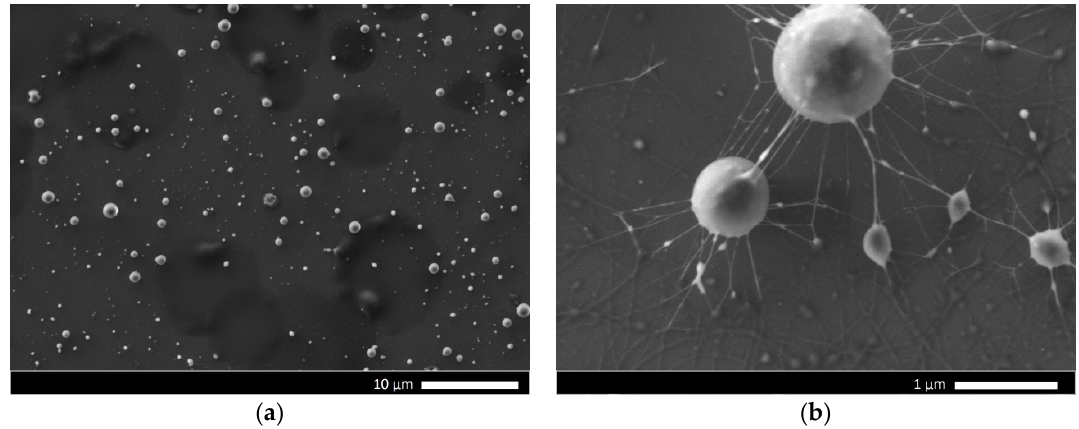
Figure 10. SEM photomicrographs of nanoparticles electrosprayed from the hyaluronic acid solutions with concentration 10.0 mg/mL under 30 kV: ( a ) magnification 4000×; ( b ) magnification 42,000×.